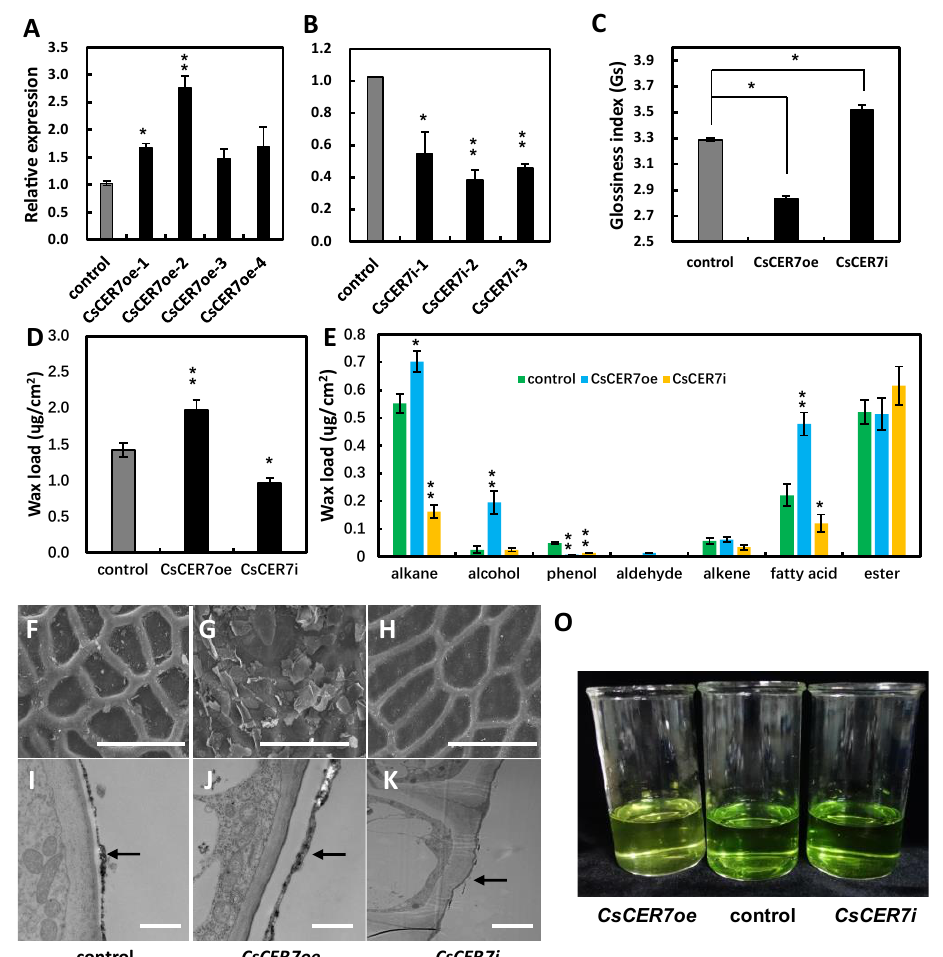
Figure 5. CsCER7 regulates cucumber wax content in cucumber. ( A , B ) qRT-PCR analyses of CsCER7 in control, various CsCER7 overexpressing ( A ) and CsCER7 -RNAi lines ( B ). ( C ) Fruit glossiness value of 9 DAA fruit in control, CsCER7i , and CsCER7oe lines. ( D ) The cuticular wax load of 9 DAA fruit in control, CsCER7oe , and CsCER7i lines. ( E ) The cuticular wax composition of 9 DAA fruit in control, CsCER7oe , and CsCER7i lines. The data of columns are the mean ± standard deviation. ( F – H ) Epicuticular wax crystal formation on 9 DAA fruit surfaces of control ( F ), CsCER7oe ( G ), and CsCER7i ( H ) plants by SEM. ( I – K ) The wax layer on 9 DAA fruit surfaces of control ( I ), CsCER7oe ( J ), and CsCER7i ( K ) plants by TEM. The arrows indicate the wax layer. ( O ) Chlorophyll permeation test of different transgenic CsCER7 cucumber lines. * means p < 0.05, ** means p < 0.01, Student’s t -test. Scale bars = 40 µm in ( F – H ); 1 µm in ( I – K ).